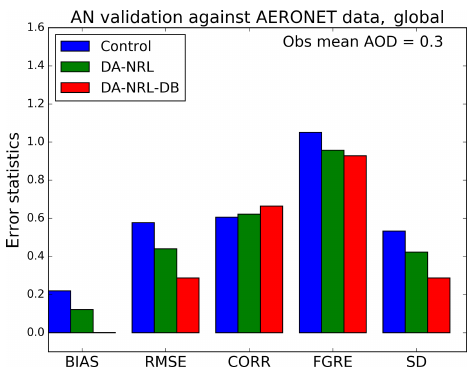
Figure 13. BIAS, RMSE, CORR, FRGE, and SD for the Control experiment, for the experiment assimilating MODIS NRL obser- vations (DA-NRL), and for the experiment assimilating MODIS NRL and MODIS Deep Blue observations (DA-NRL-DB) calcu- lated against AERONET observations for all the stations in Fig. 5. The dust mean AOD for the observations used for validation during the experiment period is also